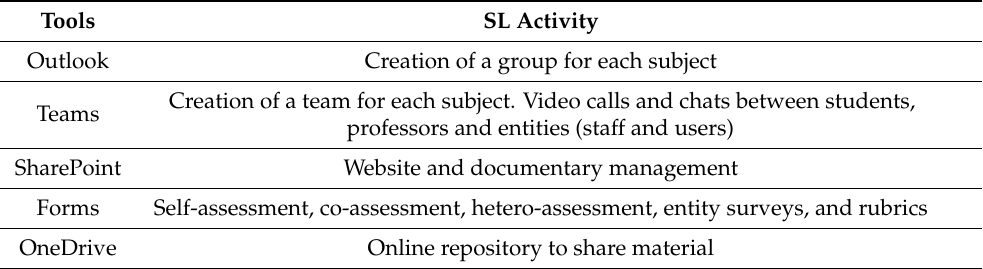
Table 3. Summary of tools used in the SL experience.